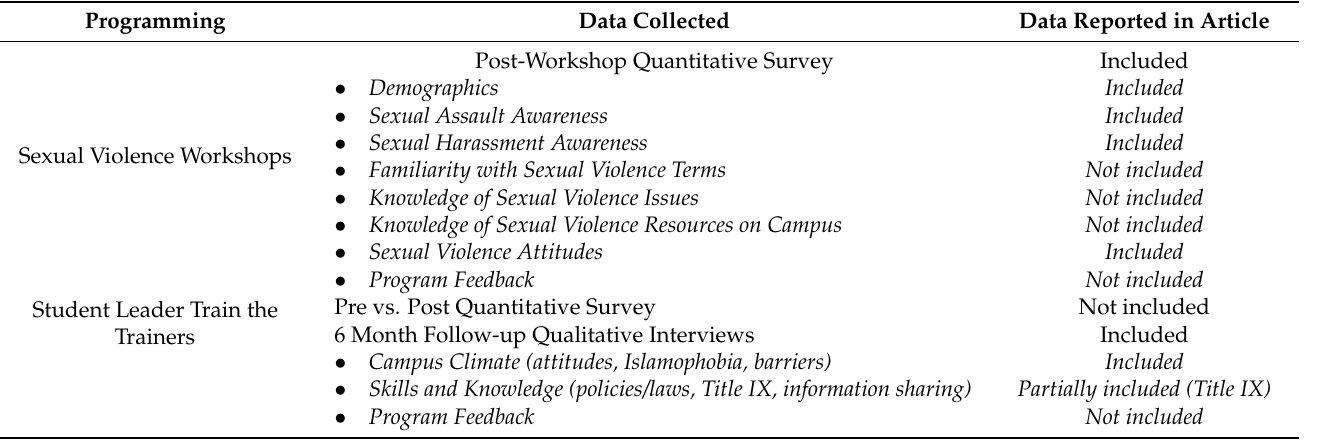
Table 1. Methods of Data Collected and